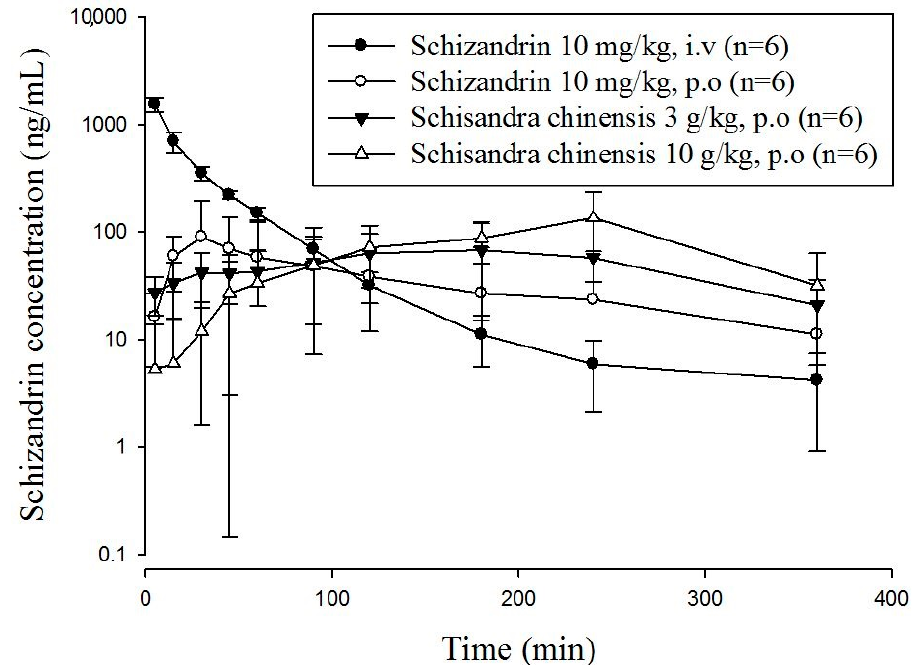
Figure 3. Concentration-time curve of schizandrin in rat plasma after intravenous (10 mg/kg, i.v.) and oral administration of S. chinensis (3 g/kg or 10 g/kg, p.o.) and schizandrin (10 mg/kg,